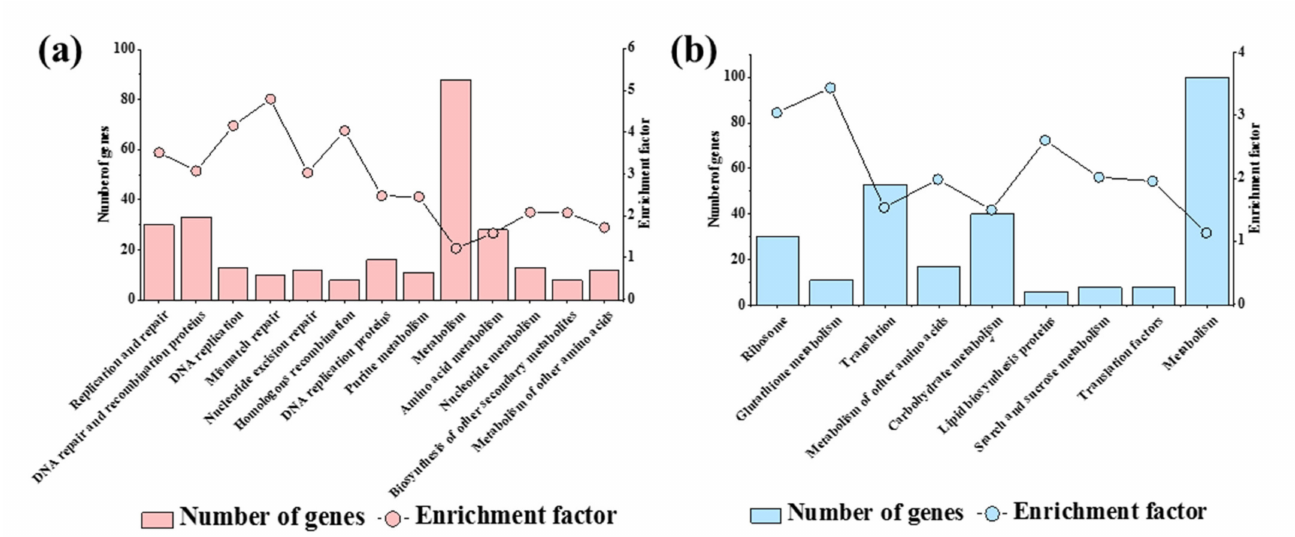
Figure 3. The KEGG enrichment analysis of DEGs. ( a ) The KEGG enrichment analysis of the up-regulated genes. ( b ) The KEGG enrichment analysis of the down-regulated